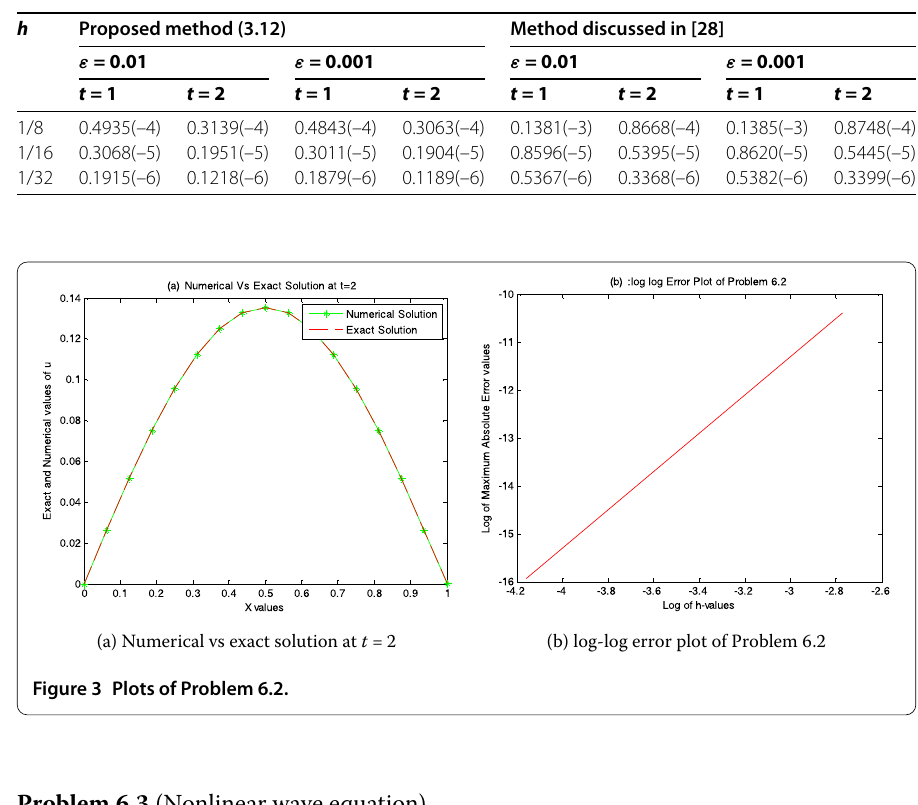
Table 3 Problem 6.2: The maximum absolute